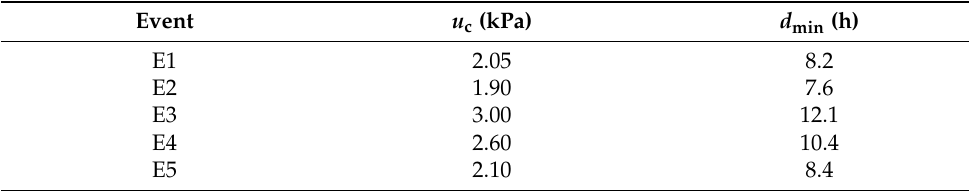
Table 2. Calculated values of u c and d min for each rain event